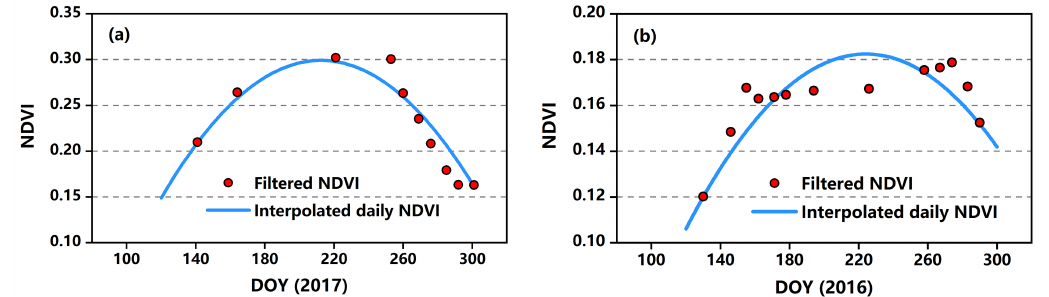
Figure 2. The filtered NDVI and the interpolated daily NDVI for the 2017 growing season of the Tamarix site ( a ) and the 2016 growing season of the Populus site ( b ). The performance of the interpolation was estimated by the determination coe ffi cient (R 2 ), Nash–Sutcli ff e e ffi ciency (NSE), and the root mean square error (RMSE). The R 2 , NSE, and RMSE were 0.921, 0.887, and 0.017 for the Tamarix site, respectively. The R 2 , NSE, and RMSE were 0.698, 0.582, and 0.010 for the Populus site,